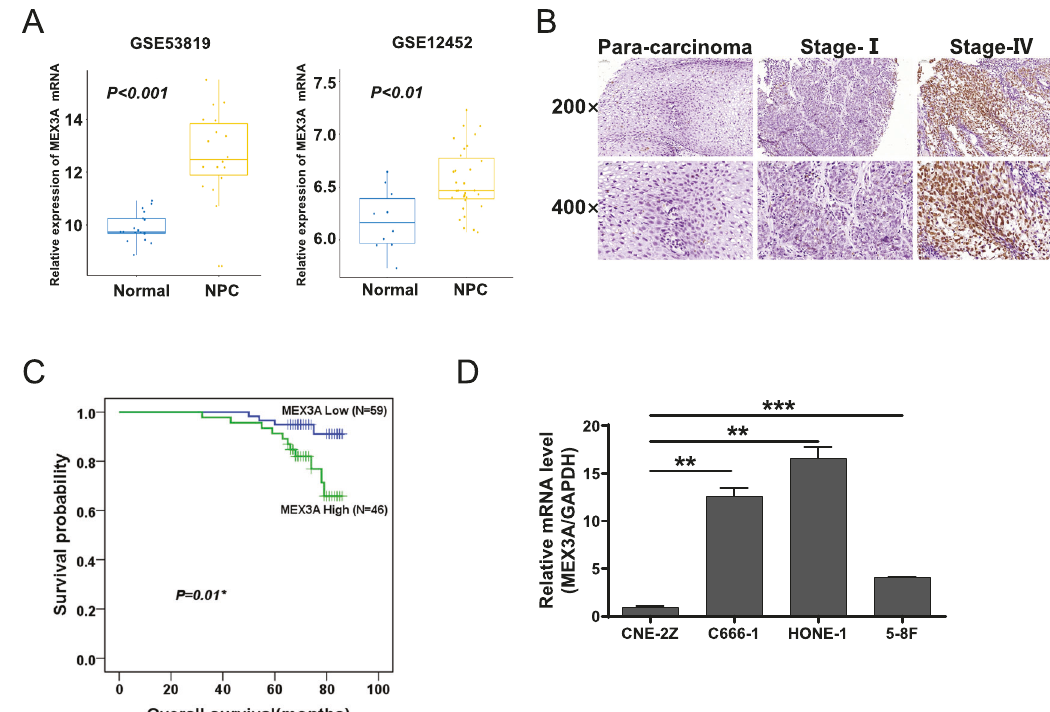
Fig. 1 MEX3A expression is high in NPC, especially in the advanced stage. A MEX3A mRNA levels were obtained from GEO datasets (GSE53819, containing 18 normal nasopharyngeal tissues and 18 NPC tissues; GSE12452, containing 10 normal nasopharyngeal tissues and 31 NPC tissues). MEX3A mRNA levels were compared between the two groups using the Wilcoxon signed-rank test. B Compared with normal nasopharyngeal tissues, MEX3A levels were higher in NPC tissues, especially in the advanced stage group. C Kaplan – Meier curves of overall survival of NPC patients with high or low MEX3A expression ( n = 105). D MEX3A mRNA levels in various NPC cell lines were detected by RT-qPCR. ** P < 0.01, *** P <